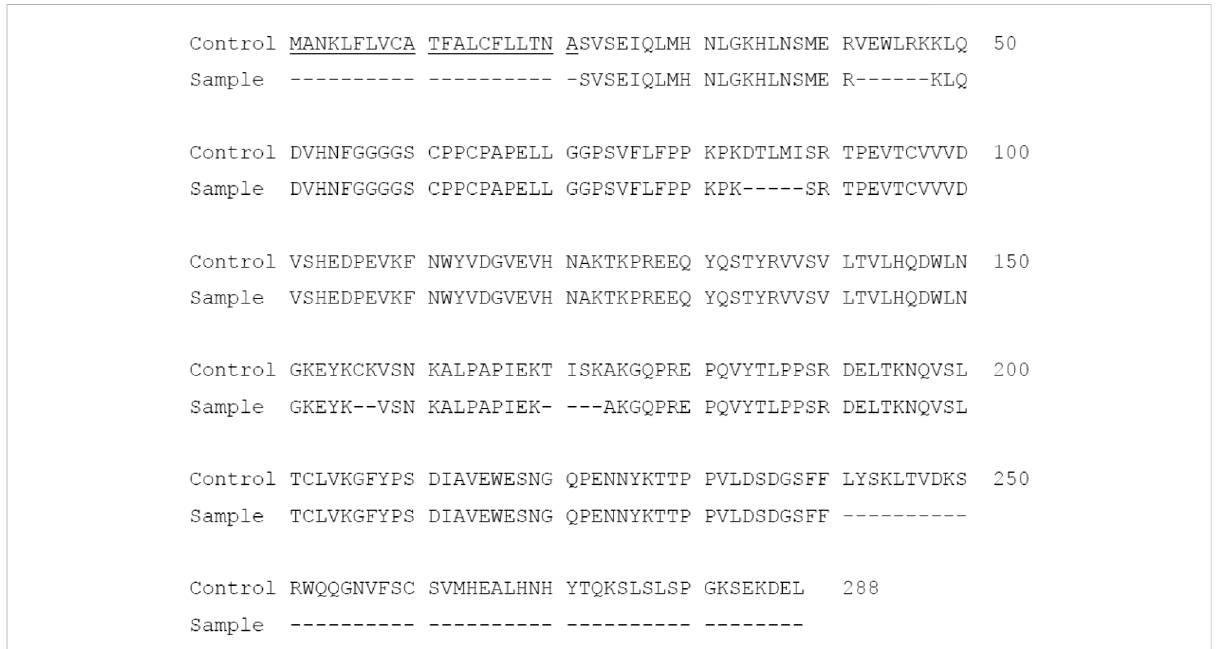
FIGURE 3 Amino acid sequence of PTH-Fc compared to the control sequence with undetected sequences represented as dashes. The underlined sequence corresponds to 2S2 secretory signal peptide.